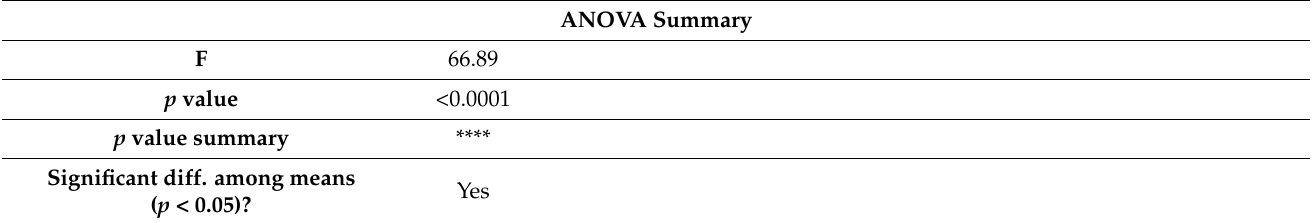
Table A6. One-way ANOVA and post-hoc Tuckey’s multiple comparison to evaluate the effect of